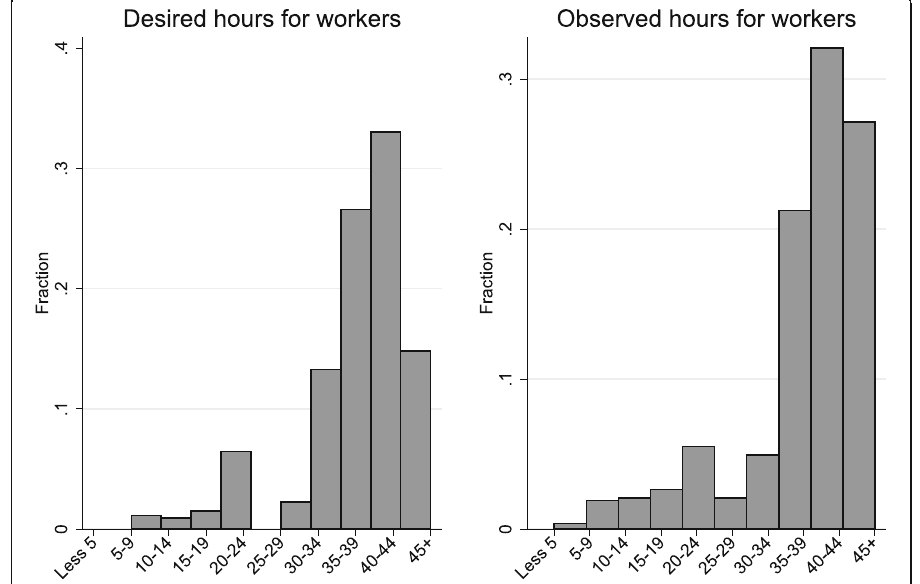
Fig. 3 Distribution of observed and desired hours for workers. Notes: 527